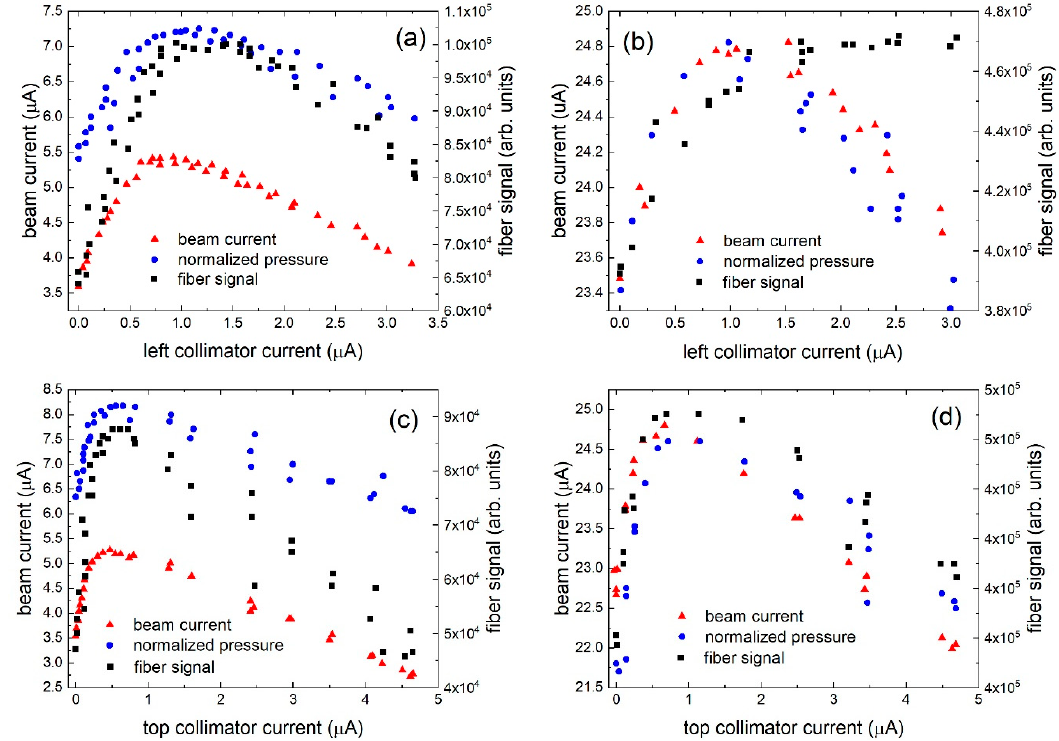
Figure 7. Beam current on target, normalized target pressure and Ce-200 fiber signal as a function of the ( a ) left collimator current at low beam current, ( b ) left collimator at high beam current, ( c ) top collimator at low beam current, and ( d ) top collimator at high beam current. Summary of n = 6 experiments using both the B-200 and Ce-200 fibers.